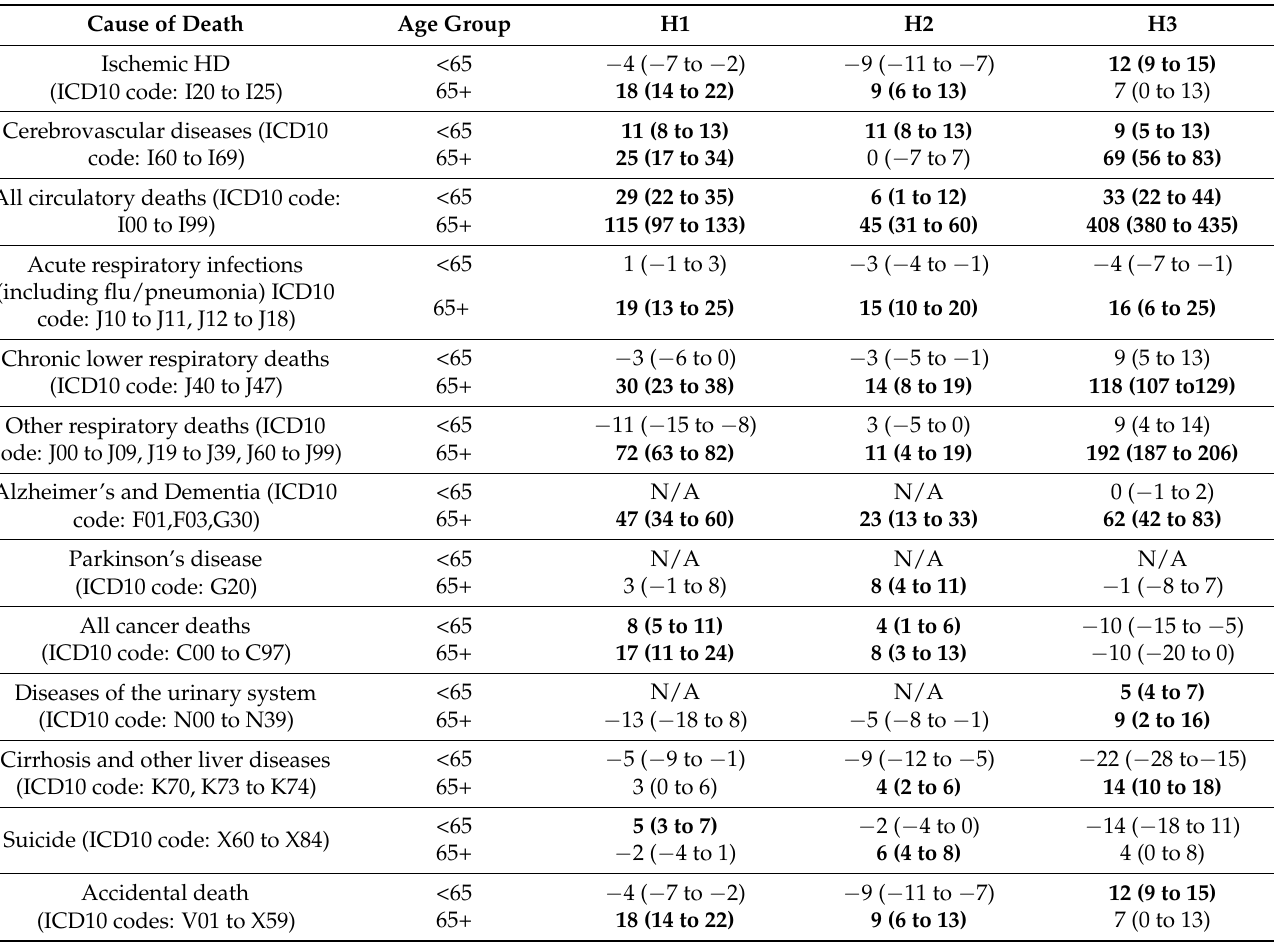
Table 3. Estimated excess mortality for specific underlying causes of death by age group in England during three heatwaves in 2020. Bold values indicate all-cause excess mortality estimates considered to be statistically significant (above 3SD), with values within the brackets the 95% Confidence